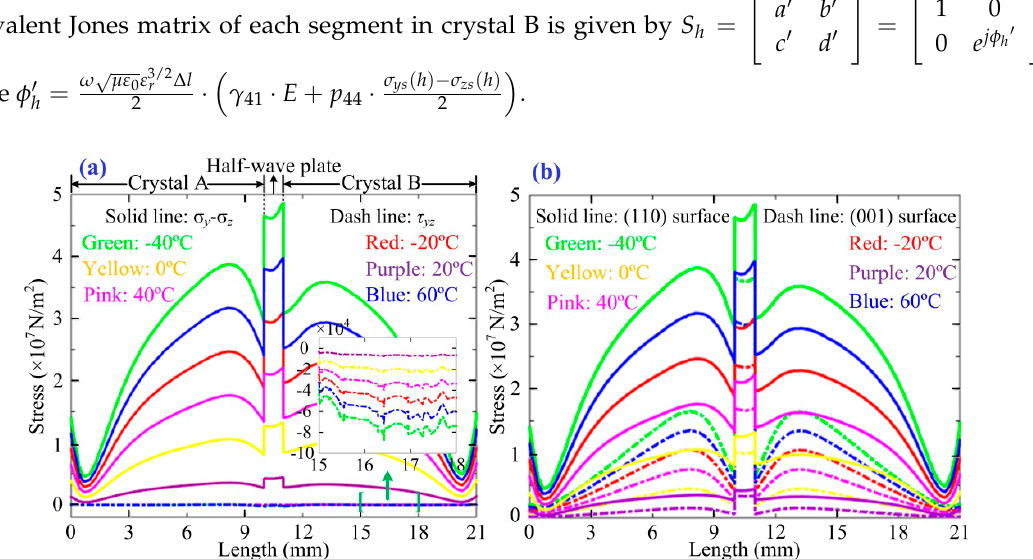
Figure 3. ( a ) Distributions of ( σ y − σ z ) and τ yz when the (110) surface of crystal is fixed on the mechanical device; ( b ) absolute values of ( σ y − σ z ) for the two different fixed methods under six different temperatures.